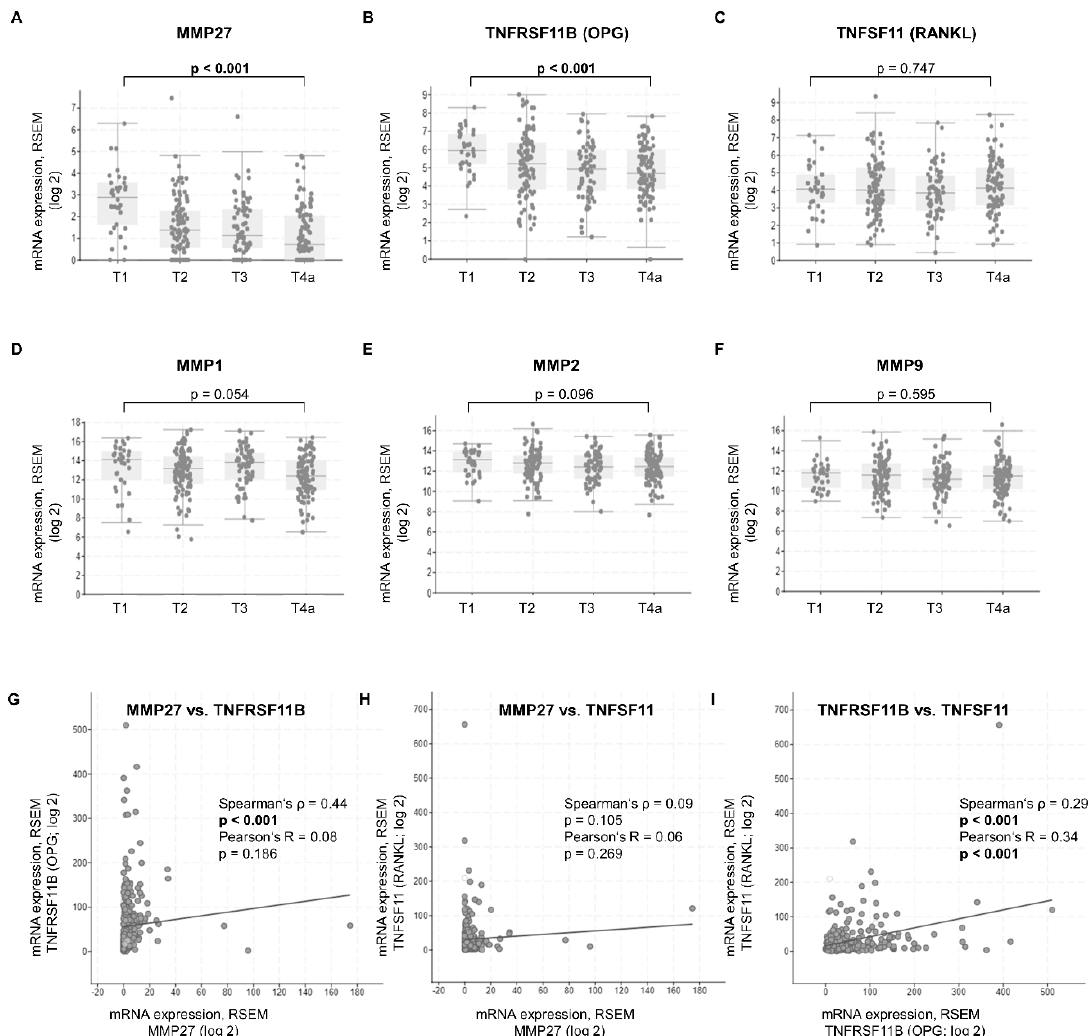
Figure 1. ( A – F ) T-stage plot of changes in mRNA expression of MMP27, TNFRSF11B (OPG), TNFSF11 (RANKL), MMP1, MMP2 and MMP9. ( A , B ) demonstrate a significant decline of MMP27 and TNFRSF11B expressions when comparing T1 to T4a HNSCC ( p < 0.001). Their mRNA